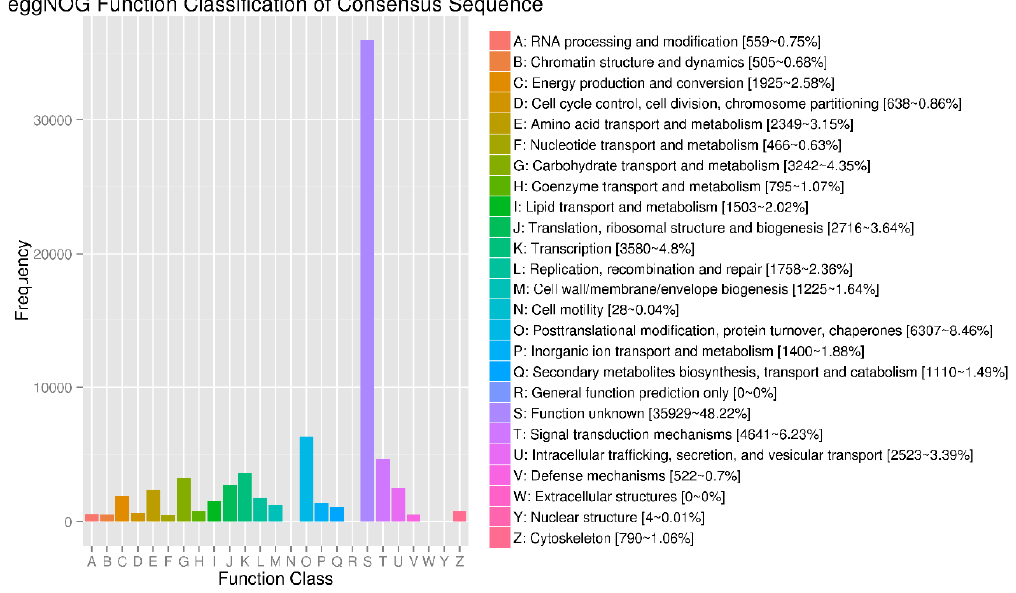
Figure A6. EggNOG function classification of the annotated high-quality transcripts obtained by TGS. The horizontal axis represents the EggNOG categories and horizontal axis represents the gene number.